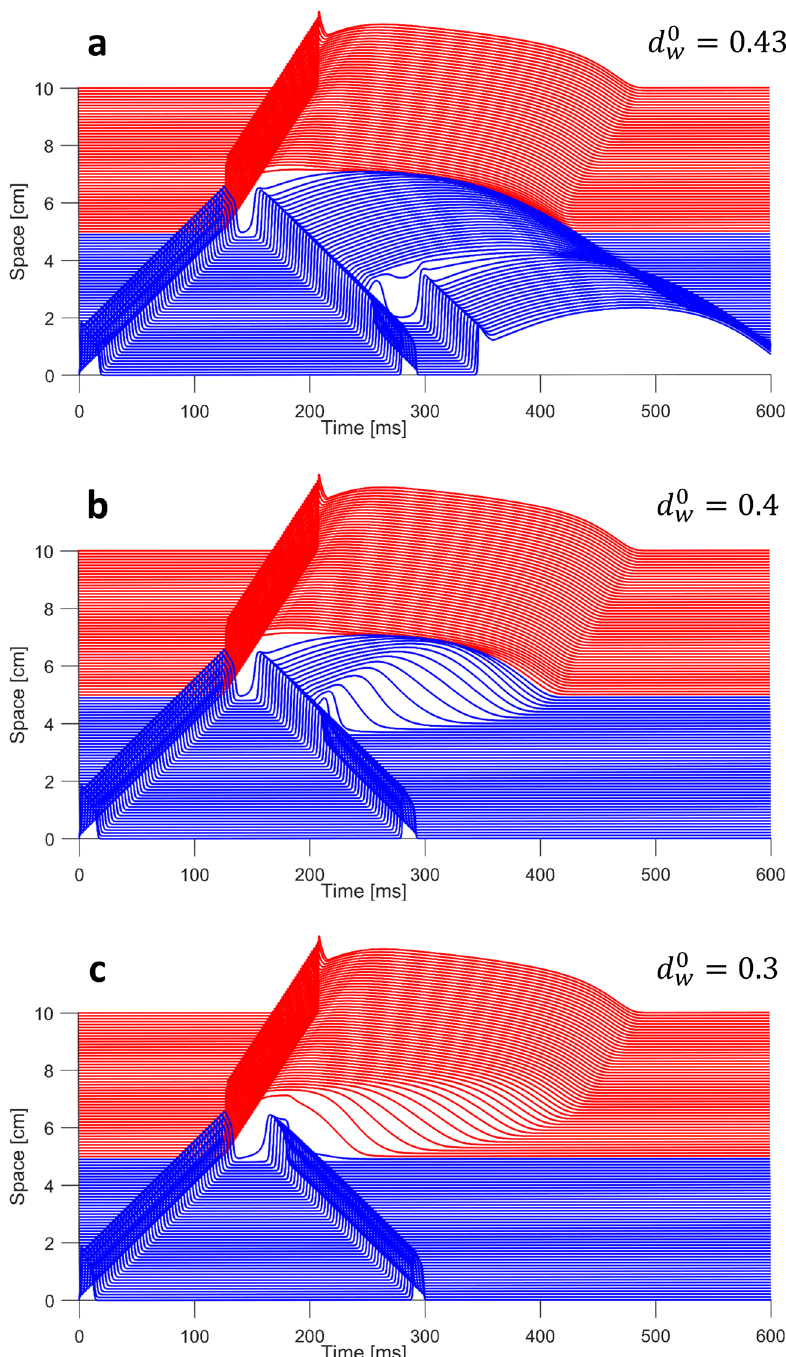
0 w . For each situation, a 0 = 0.43 ; w 0 = 0.4 ; P2R generates a delayed dome AP close to the healthy w 0 = 0.3 ; P2R generates a new lost dome w